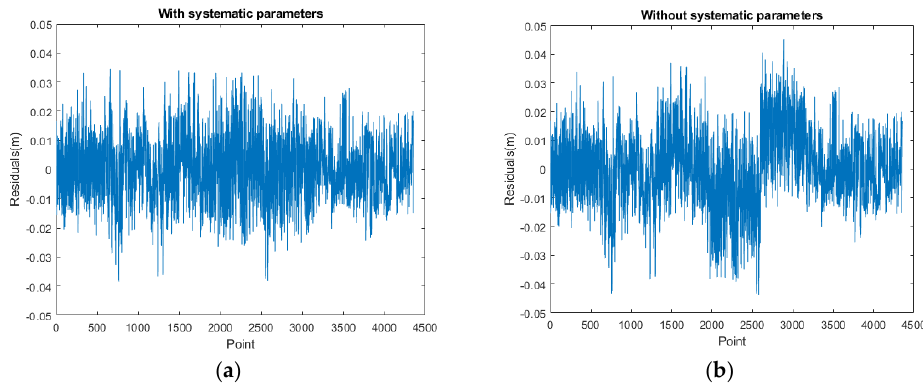
Figure 12. The residual scatter diagram of calibration data. ( a ) With APs. ( b ) Without APs.